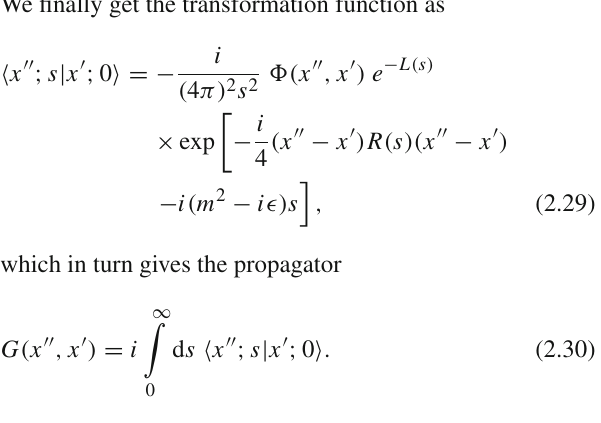
This integral is evaluated in Appendix A to give C = − i /( 4 π) 2